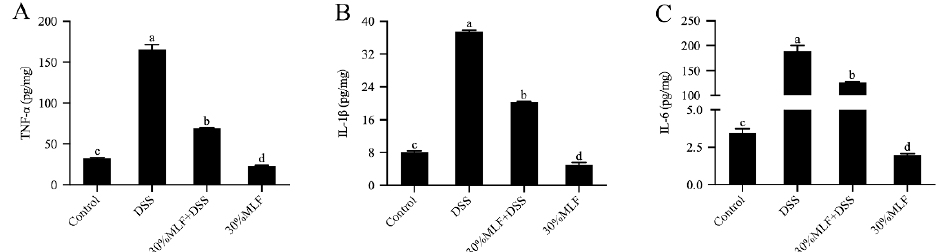
Figure 9. Effects of 30%MLF on the inflammatory cytokine secretion of mice with DSS-induced ulcerative colitis. ( A ) TNF- α , ( B ) IL-1 β , and ( C ) IL-6 production in colon tissue was measured by ELISA. Data are presented as the means ± SD ( n = 3). Columns with different superscript letters are significantly different ( p < 0.05).